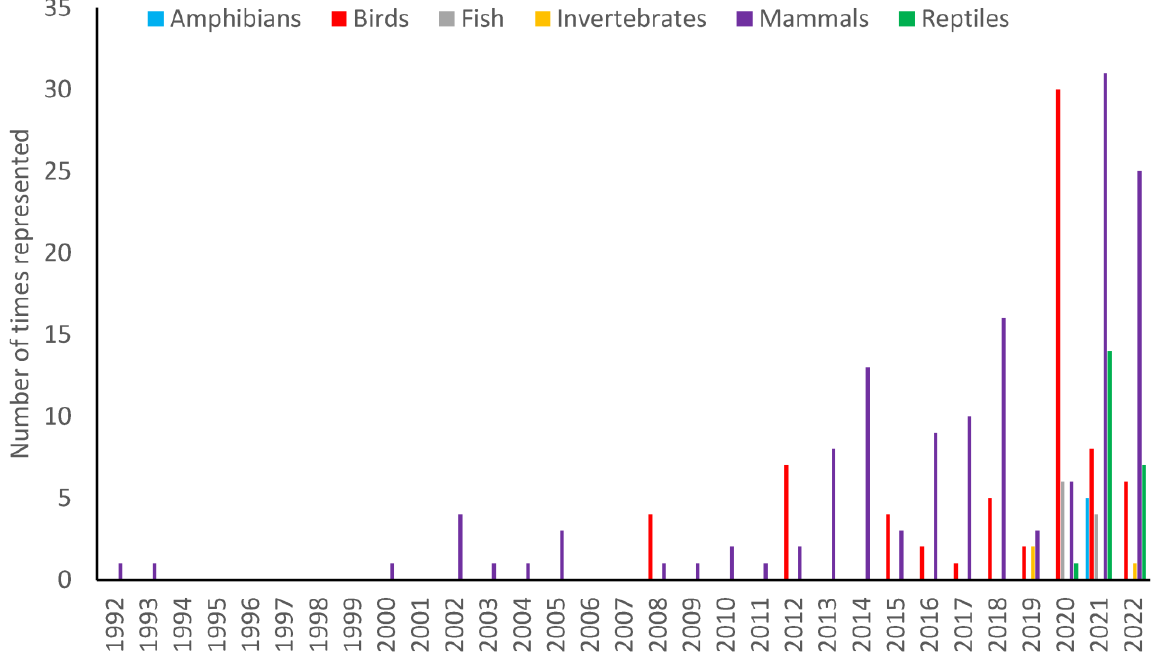
Figure 3. An overview of taxa represented in the study papers from 1992 to 2022.